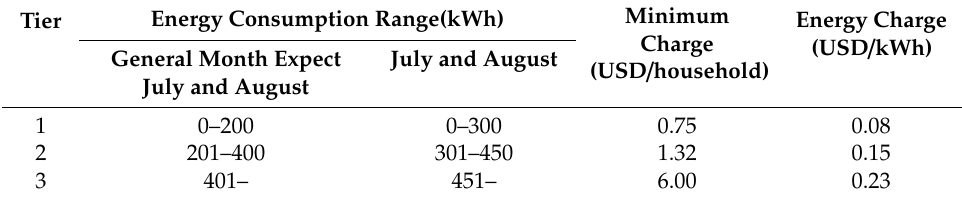
Table 7. Progressive electricity tari ff s for residential services.